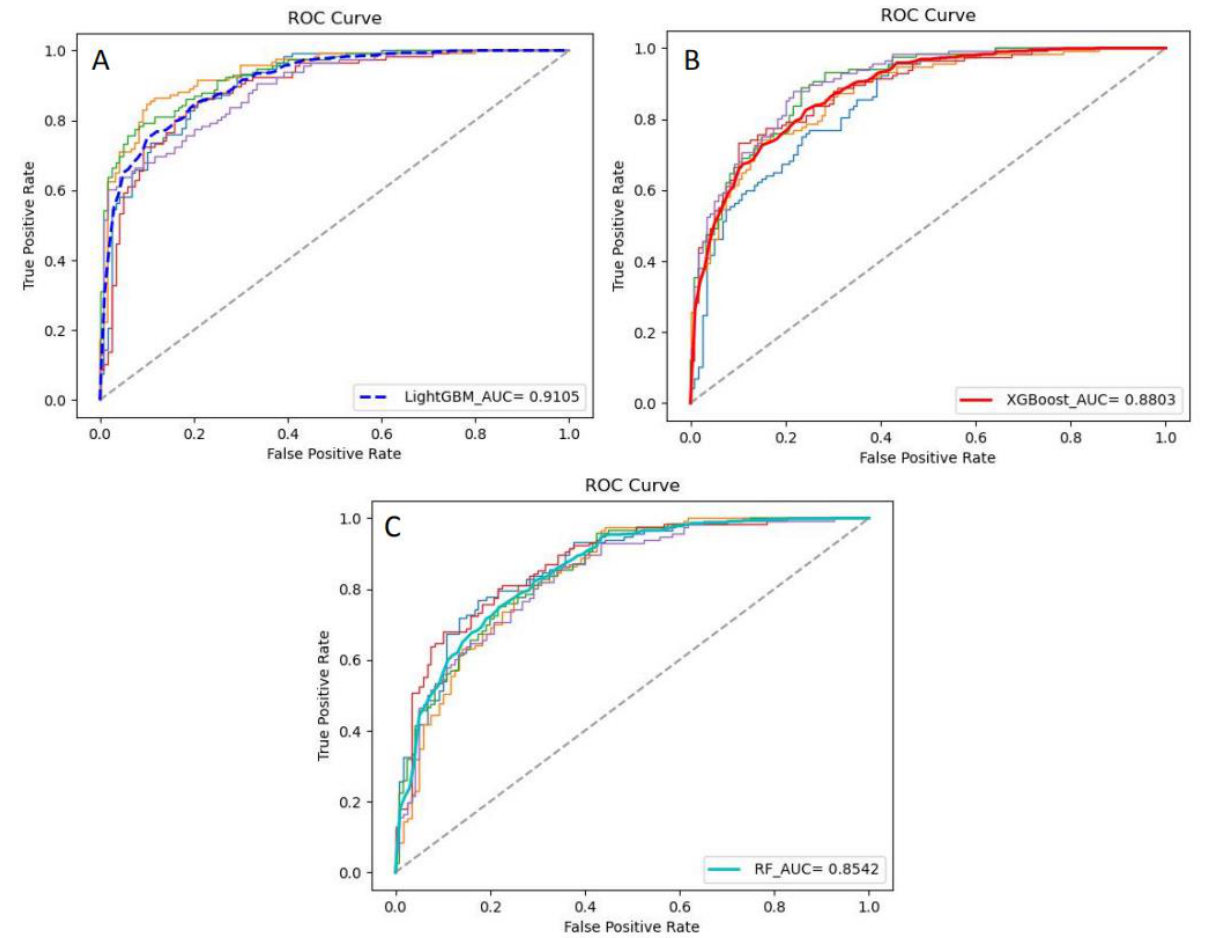
Figure 6. ROC curves and corresponding AUC values of the ensemble models. ( A ) is the ROC curves and AUC value of LightGBM; ( B ) is the ROC curves and AUC value of XGBoost; ( C ) is the ROC curves and AUC value of RF.